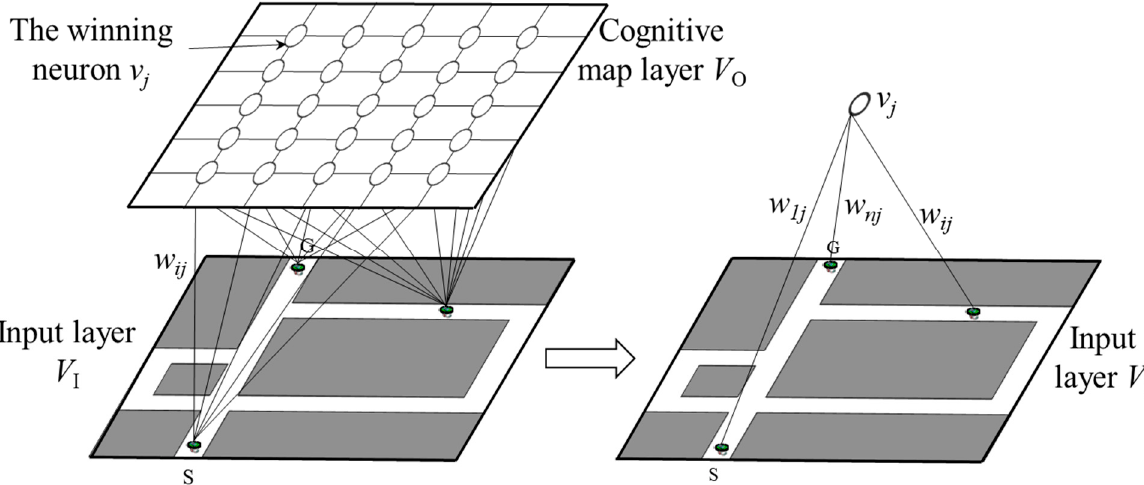
Figure 3. The “sense-response” structure of the DGP-PCCMM. The DGP-PCCMM has two layers: a sensory input layer V I and a cognitive map layer V O . As the input of the network, the V I layer interacts with the external environment, sensing and obtaining external information. The V O layer can be seen as the brain, which can form a feature map of the environment. The generated topological map can exist in either of the two forms: the connection weight W between the input and output layer or the winning neurons in the output layer. We choose the former to represent the generated cognitive map.